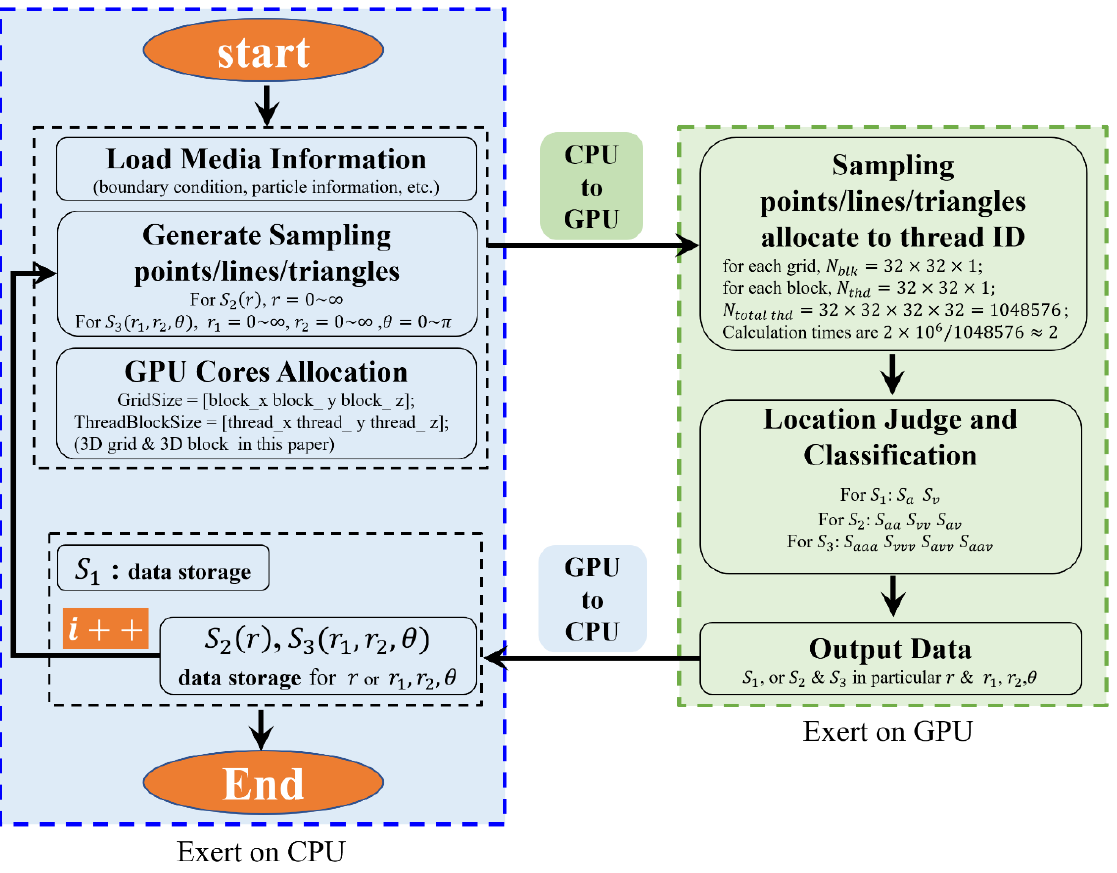
Figure 4. Flowchart of GPU ‐ based parallel computing algorithm. Table 1. Total consumption times of the GPU and CPU on packing system of